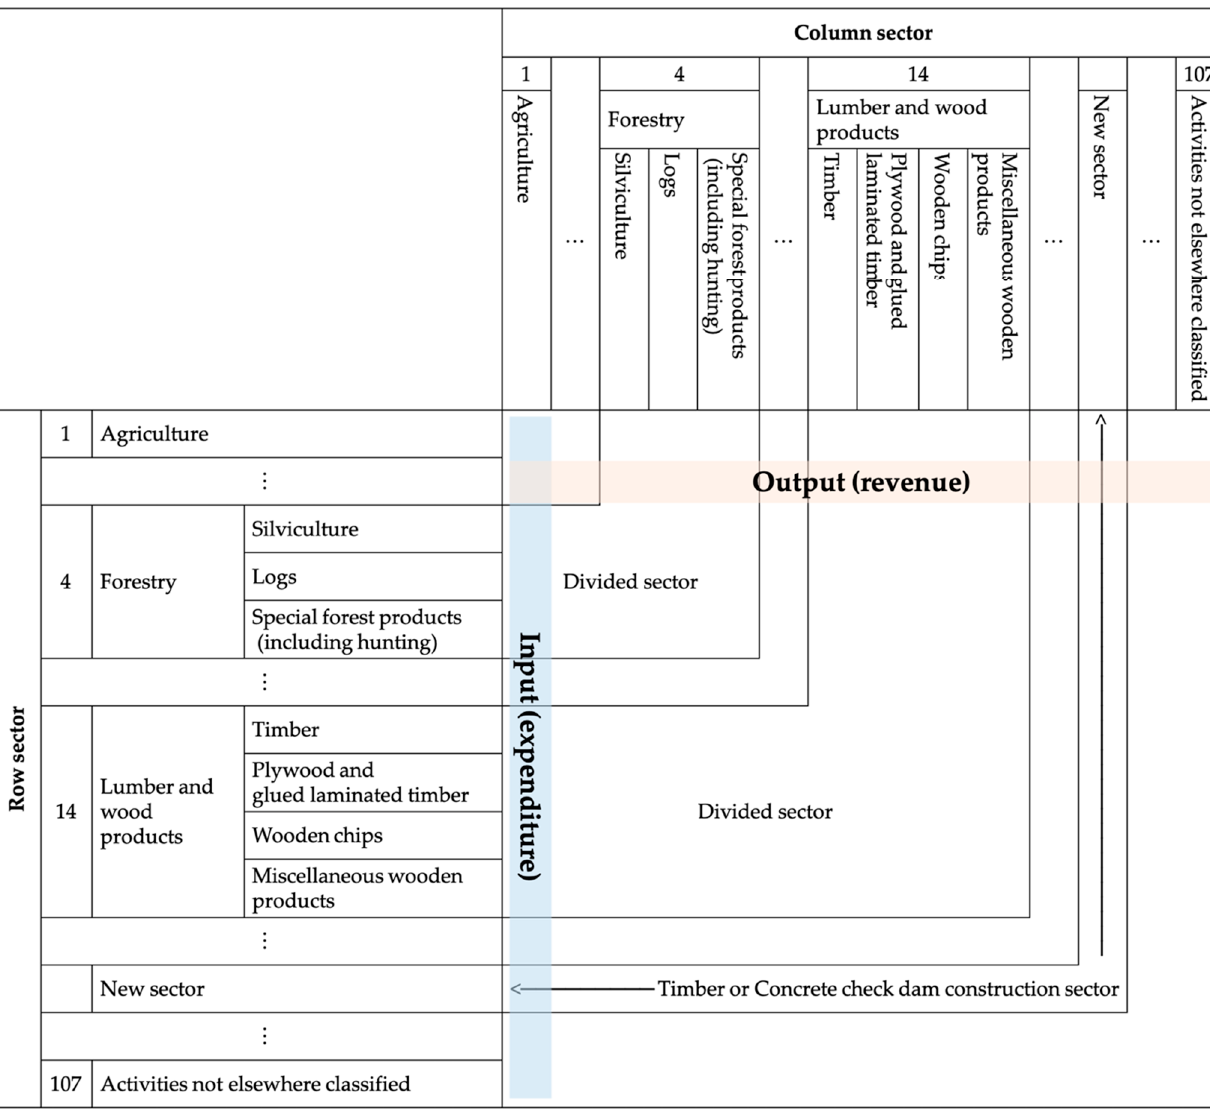
Figure 4. Schematic table of the extended input–output table (Extended Akita Table).